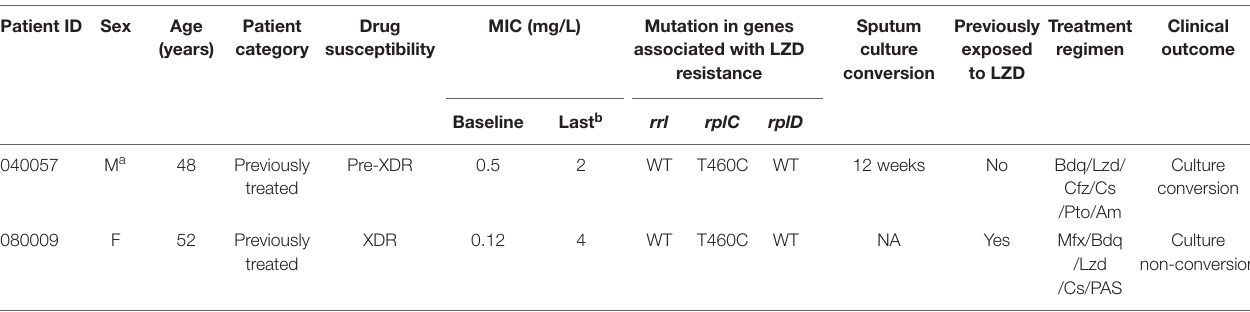
TABLE 2 | Patients with elevated MICs after exposure to